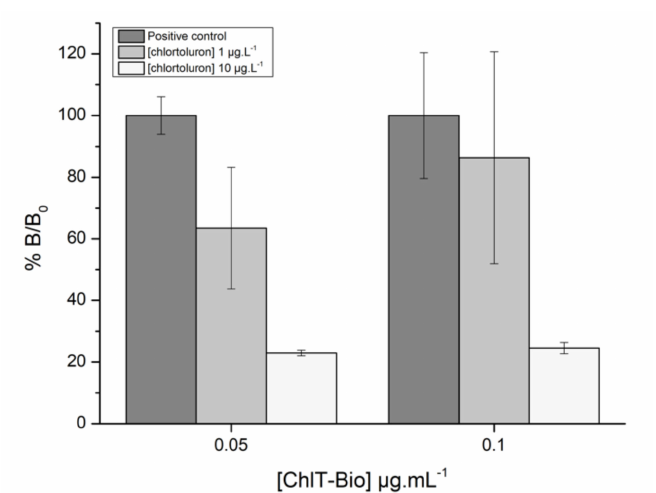
Figure 8. Relative response showing %B/B 0 obtained for chlortoluron detection (1 and 10 µ g · L − 1 ) using electrodes coated with biotinylated chlortoluron (ChlT-Bio) at 0.05 or 0.1 µ g · mL − 1 . Streptavidin and primary antibody concentrations were fixed at 5 and 0.6 µ g · mL − 1 , respectively.